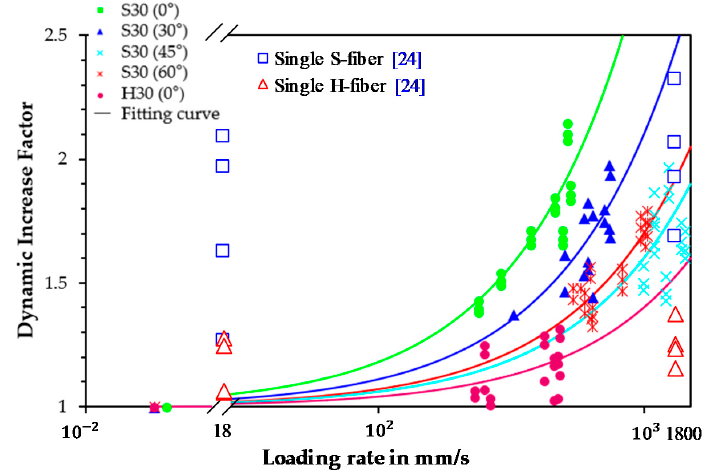
Figure 14. DIF versus loading rate relationship for S- and H-fibers in UHPC.